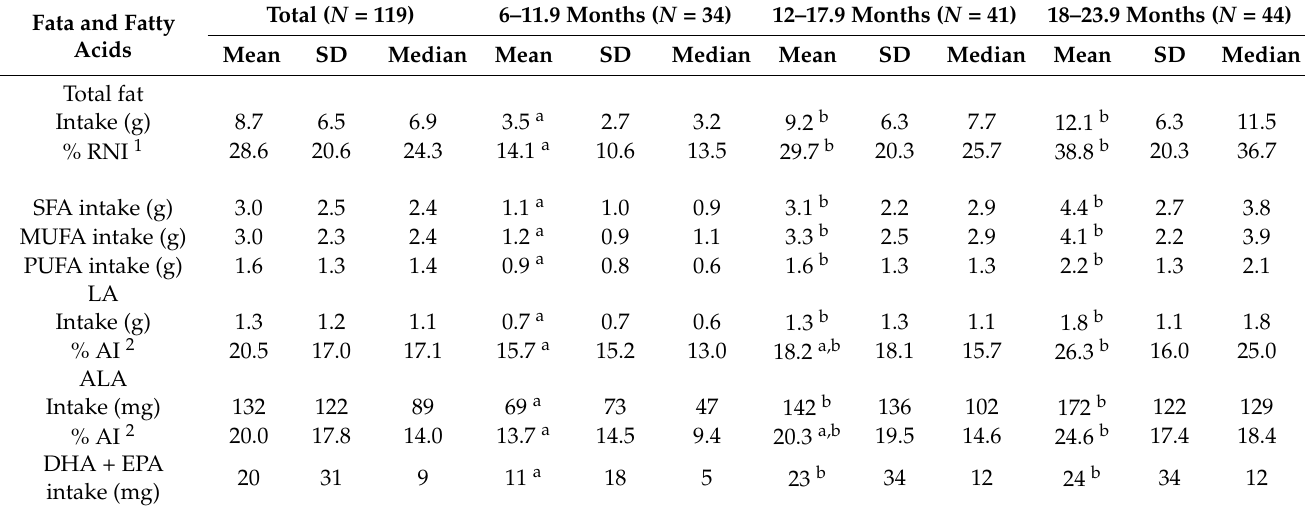
Table 4. Intake of fats and fatty acids from complementary foods (mean ± SD and median) according to age group. Fata and Fatty